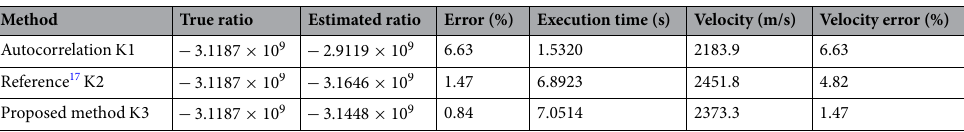
Table 2. Performance comparison of estimation